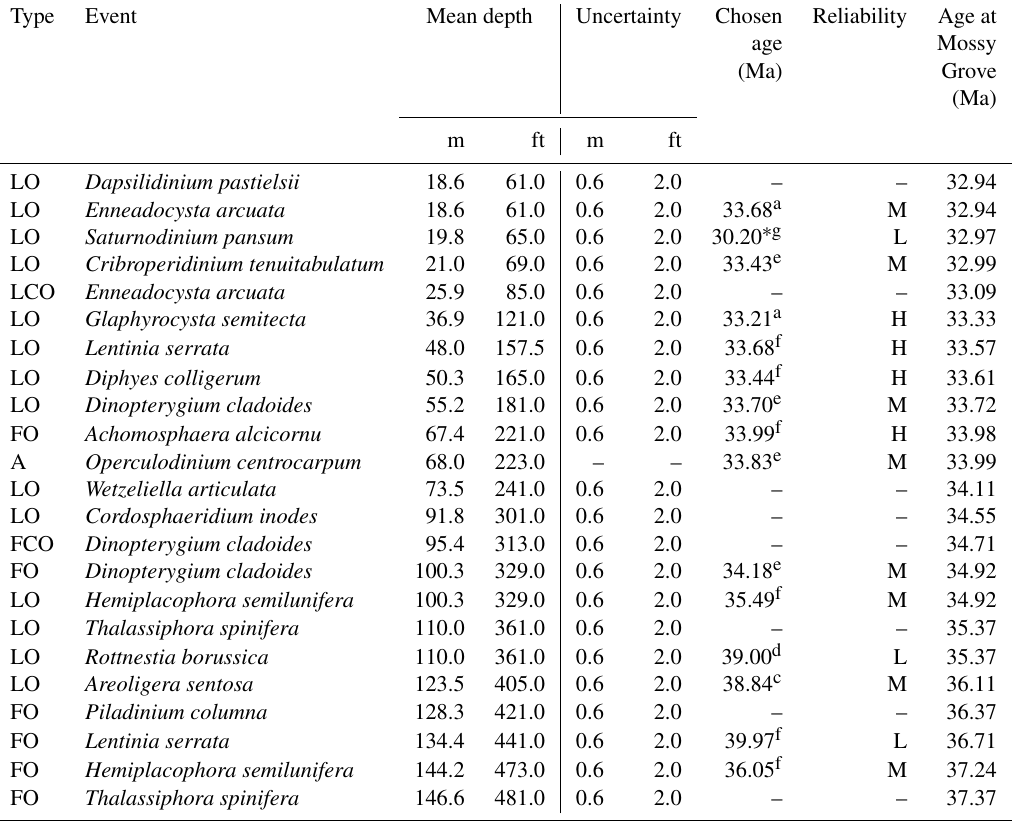
Table 2. List of dinocyst bioevents recorded in the section. Reliability rating and absolute ages were assigned for selected events. Timescale follows Westerhold et al. (2014). The last column presents ages calculated from the age–depth model provided by this study (see Sect. 3.4). Legend: FO represents first occurrence; LO represents last occurrence; FCO represents first common occurrence; LCO represents last com- mon occurrence; A represents acme; ∗ represents age available only after the timescale of Pälike et al. (2006); H represents high reliability; L represents low reliability; and M represents moderate reliability.